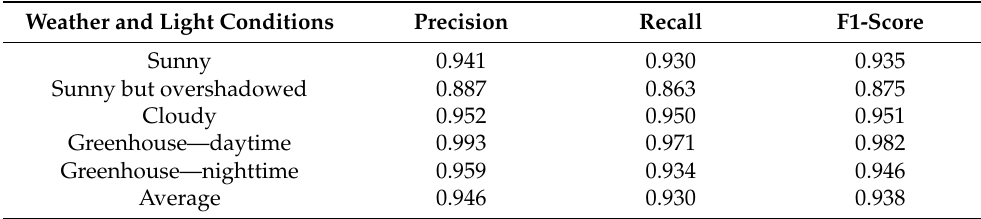
Table 1. Performance of the proposed model under different weather and light